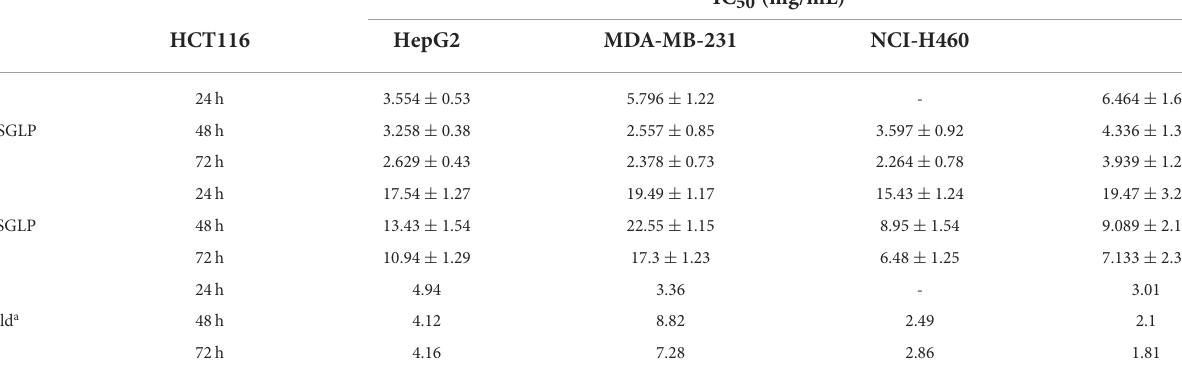
TABLE 1 Half-maximal inhibitory concentration (IC 50 ) of RSGLP and BSGLP against the human cancer cell lines (HCT116, HepG2, MDA-MB-231, and